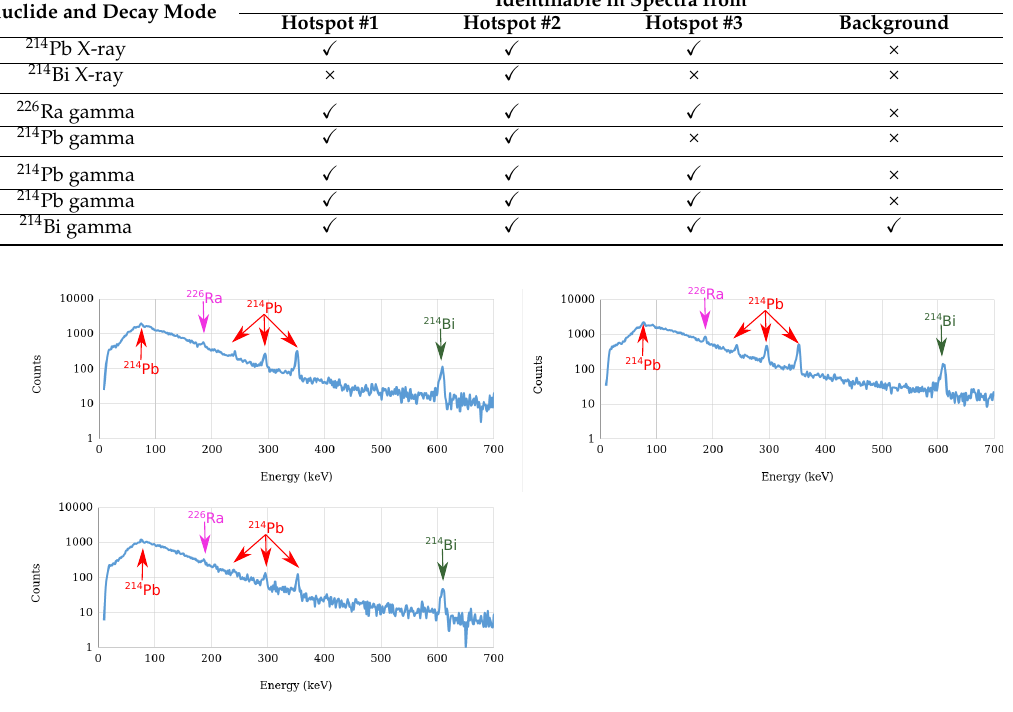
Figure 28. Spectra acquired with the CZT at Hotspot #1,#2 and #3, in Scenario C. The peaks identified using InterSpec [48] are marked with arrows. The acquisition time was approximately 32 min.